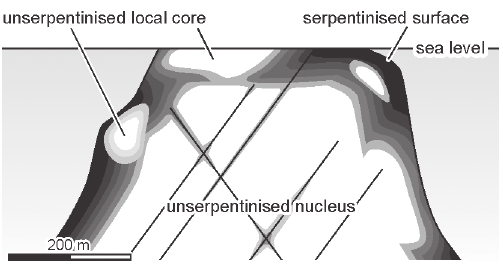
Figure 12 - Schematic cross section for the serpentinisation of Saint Peter and Saint Paul peridotite ridge, Equatorial Atlantic Ocean. The scale is not